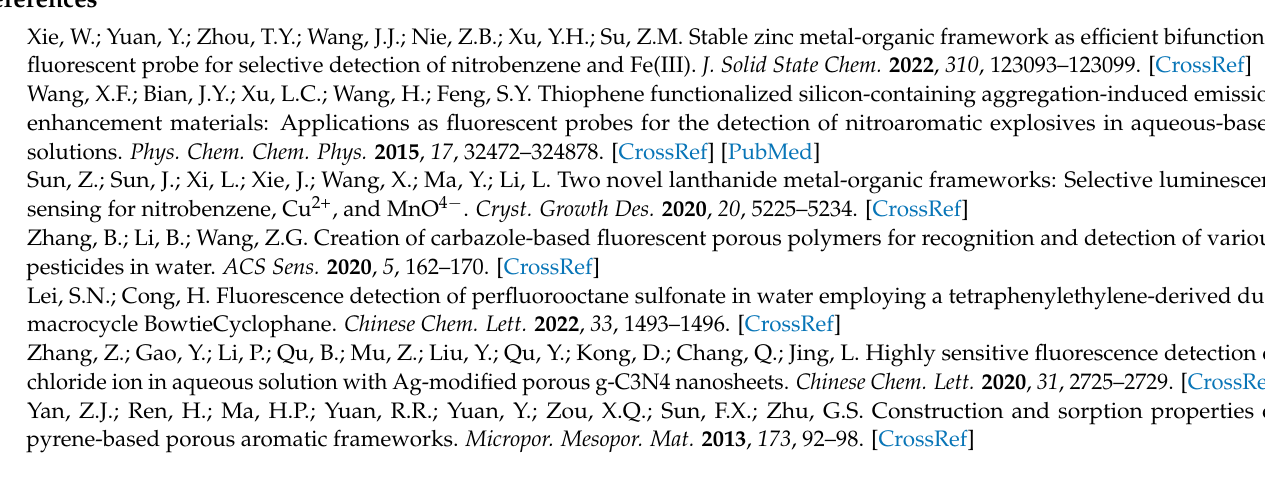
and LNU-23, Figure S5: Luminescence photographs of LNU-23 powder under UV irradiation at 365 nm, Figure S6: Stern–Volmer plot of LNU-23 treated with nitrobenzene at different concen- trations, Figure S7: ( a ) SEM image of blank filter paper, ( b ) LNU-23-loaded paper, and ( c ) paper sensor soaked in absolute ethanol, Figure S8: Preparation process of LNU-23-loaded paper sensor, Table S1: Summary of luminescent probes for NB sensing. References [49–52] are cited in the supplementary